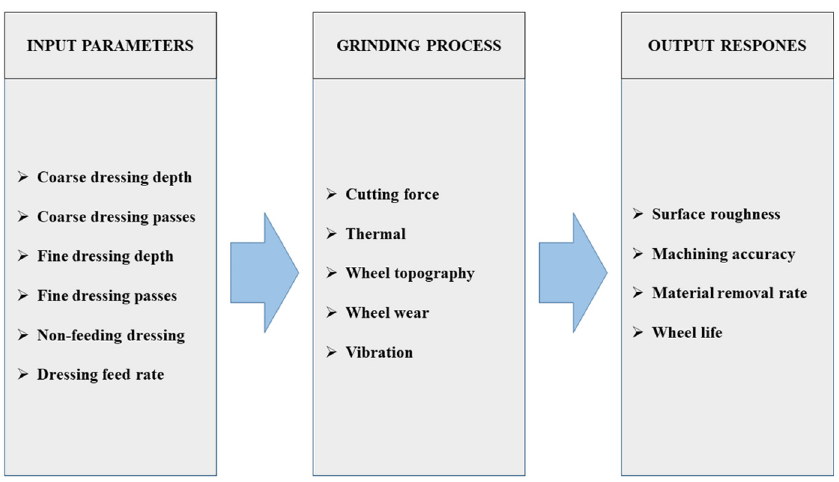
Figure 1. Experimental